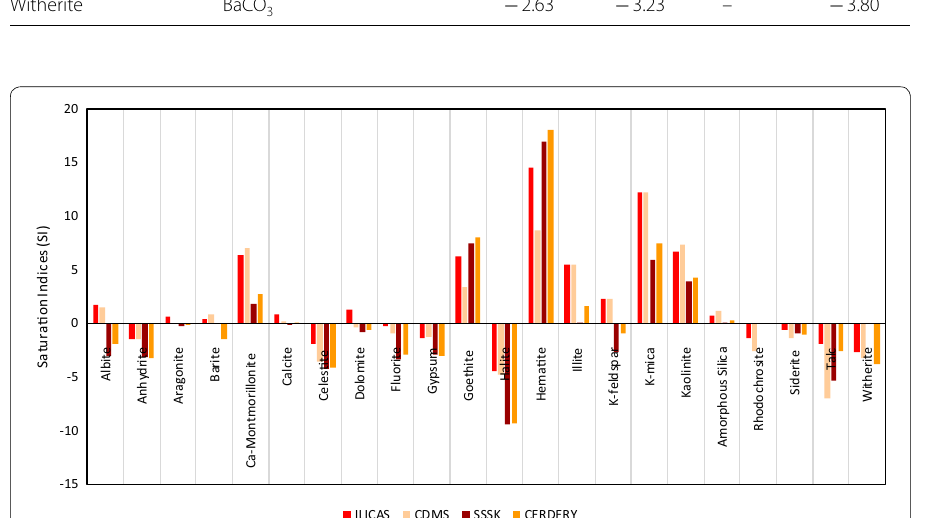
Fig. 9 Mineral saturation indices (SI) for selected minerals in the Şavşat Geothermal